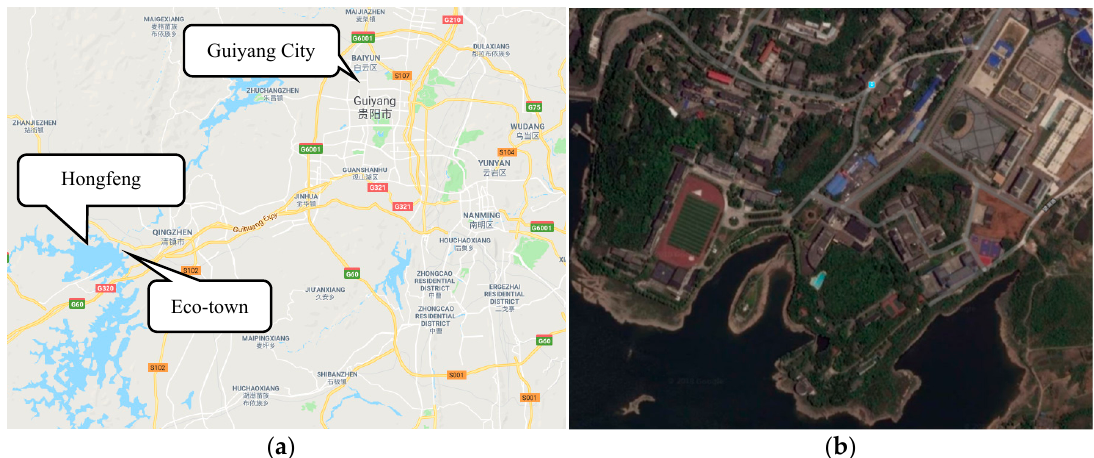
Figure 5. Hongfeng Eco-town on Google Maps: ( a ) geographical location; ( b ) satellite image.